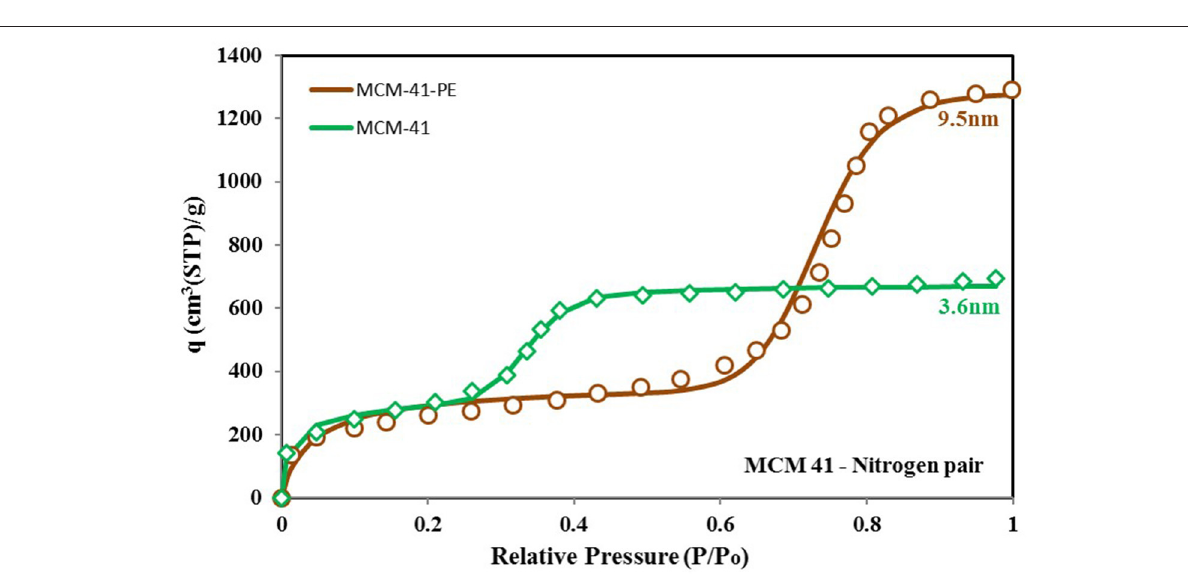
FIGURE 9 | Isotherms for MCM-41 and MCM-41-PE paired with nitrogen as the adsorbate. Unlike the previously shown isotherm cases, pore expansion caused a higher uptake and caused a shift in the material’s response against relative pressure. This shift can be linked to the change in the median energy level, presented by the energy distribution